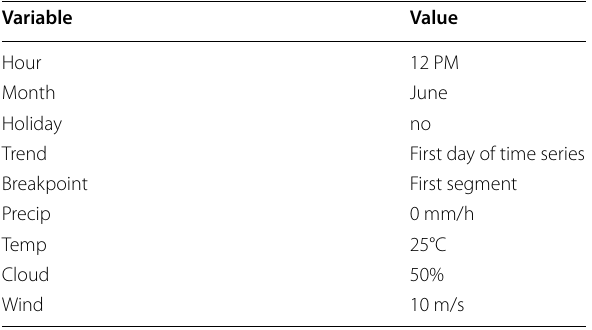
Table 6 Setting of predictor variables used for predictions of hourly vehicle counts displayed in Fig.